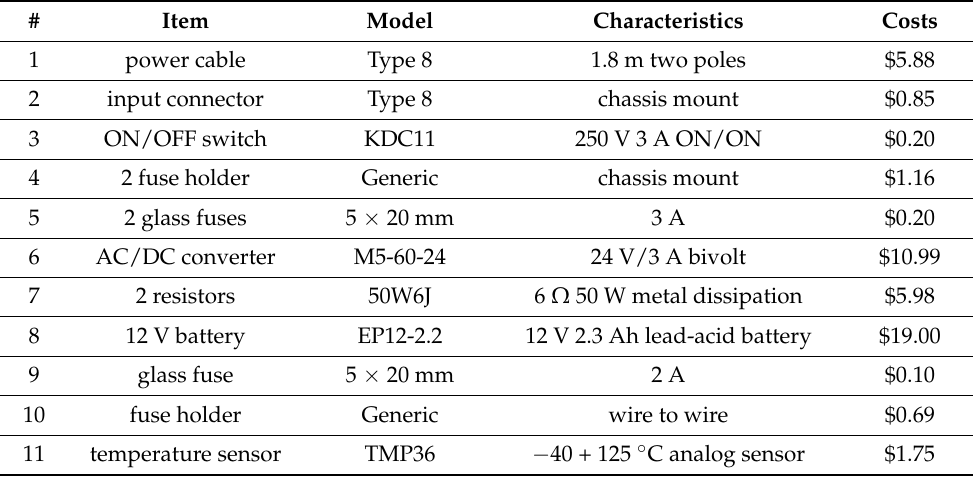
Table 1. Components of the power supply with item, model, characteristics, and costs.